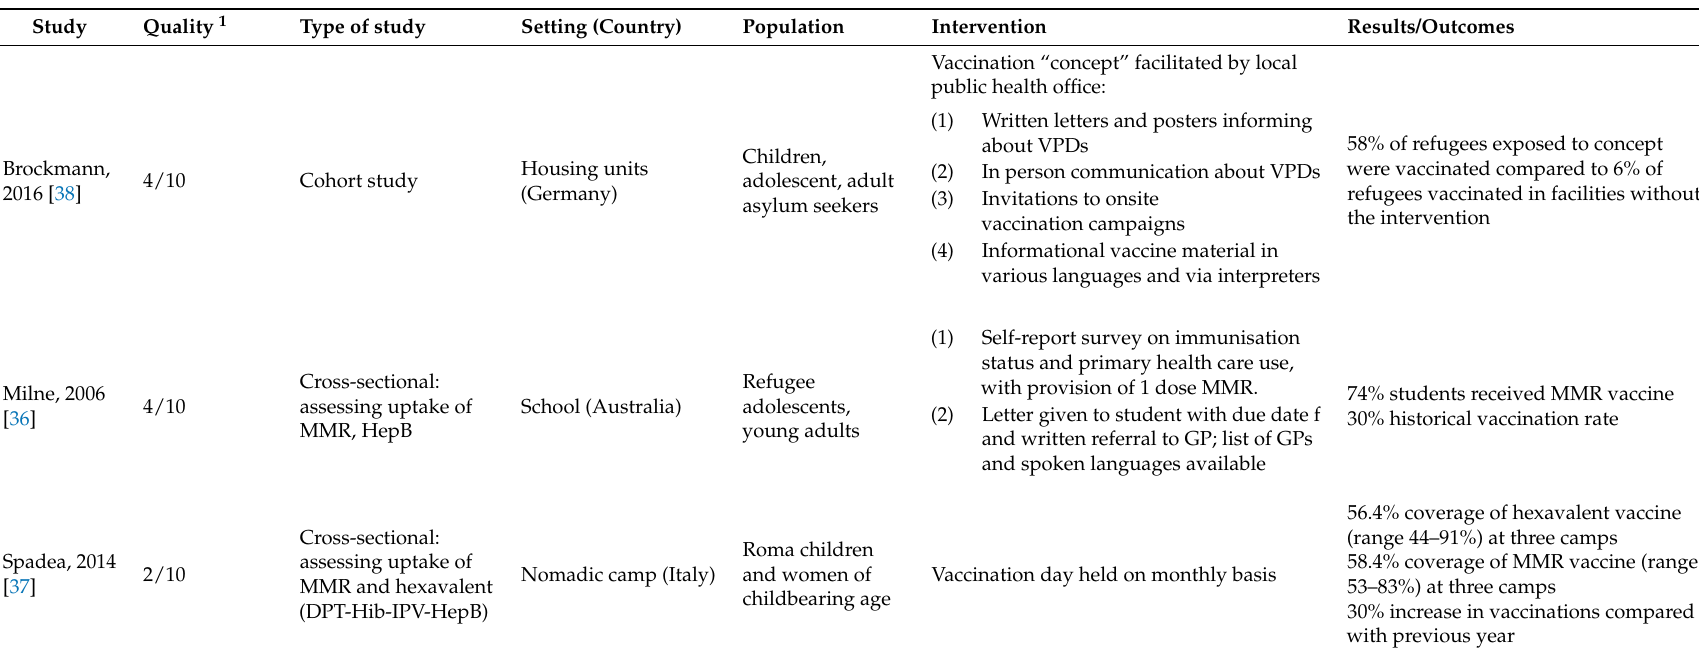
Table 1. Characteristics of included studies in high income countries—strategies to increase vaccination